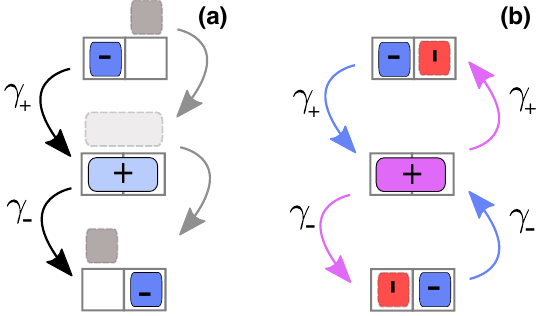
Figure 5: (a) Visualisation of the (cid:96) − = 1, (cid:96) + = 2 process, also as seen in terms of holes (in gray). (b) The symmetry becomes apparent when the extension step of a ( − ) particle is assimilated to the creation of a new object ( + ), which has characteristics of both an expanded particle and an expanded hole: the process in which holes ( | ) recede obeys exactly the same dynamics, and the same rates, as particles advancing, which implies the particle-hole symmetry. The arrows evolving from bottom to top are exploited below (section